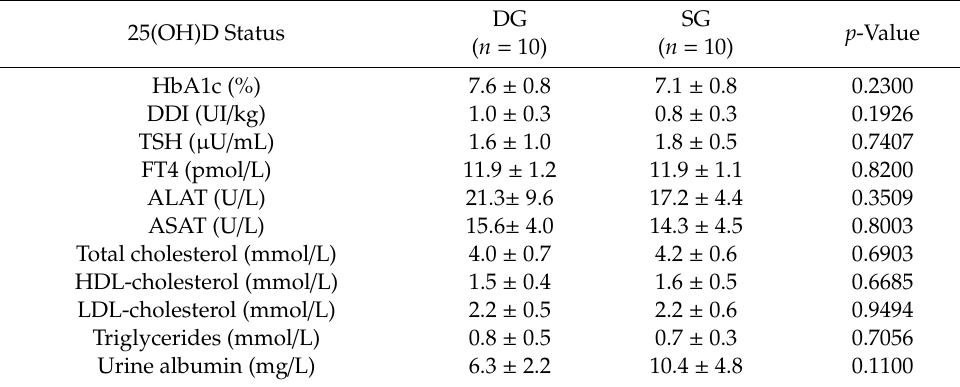
patients was more prone to hypoglycemia during mixed training days (time below range < 3.88